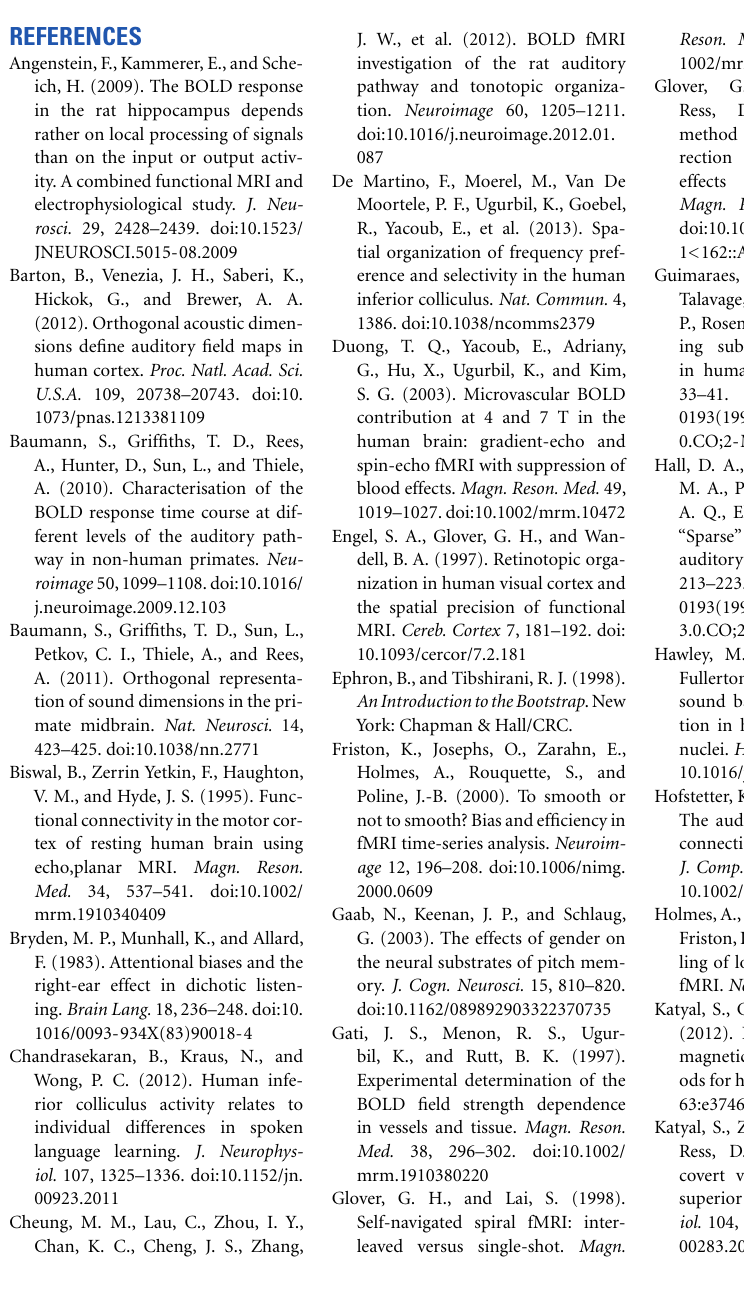
Figure S1 |Additional color overlays of centroid frequency on anatomy slices . (A,B) Sagittal and coronal views of subject 1, respectively. (C–E) Sagittal, coronal, and axial views of subject 3. Inset surface figures show slice locations on surface models of each subject’s midbrain. Figure S2 | Depth gradients obtained from data blurred with 2-mm FWHM kernel . Same format at Figure 5